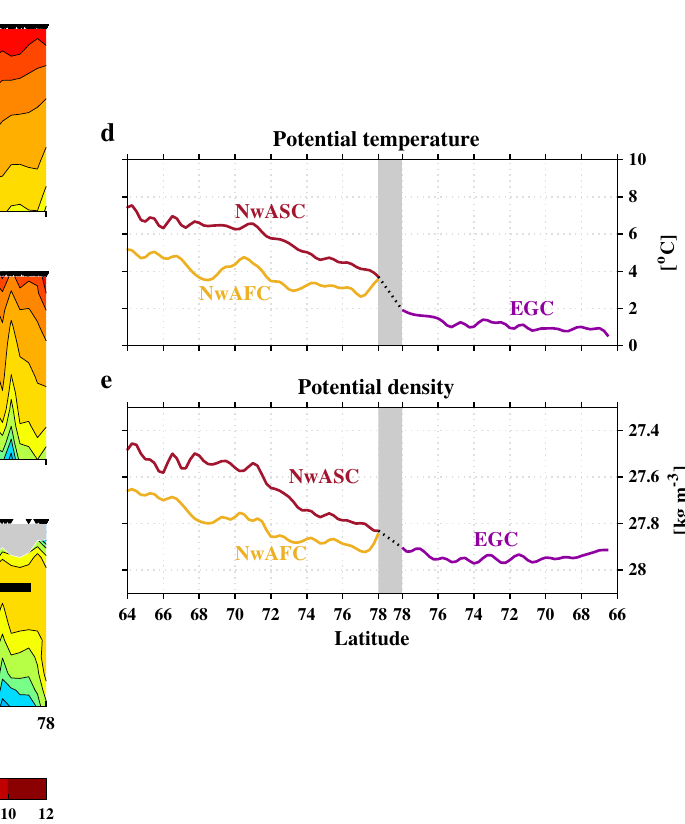
data points are indicated along the top of the plots. Depth-mean changes of ( d ) potential temperature and ( e ) potential density for the Atlantic Water layer along the NwASC (red), NwAFC (yellow), and EGC (purple). The transition portion that connects the two branches of the Norwegian Atlantic Current and the EGC is marked by the dotted line and gray